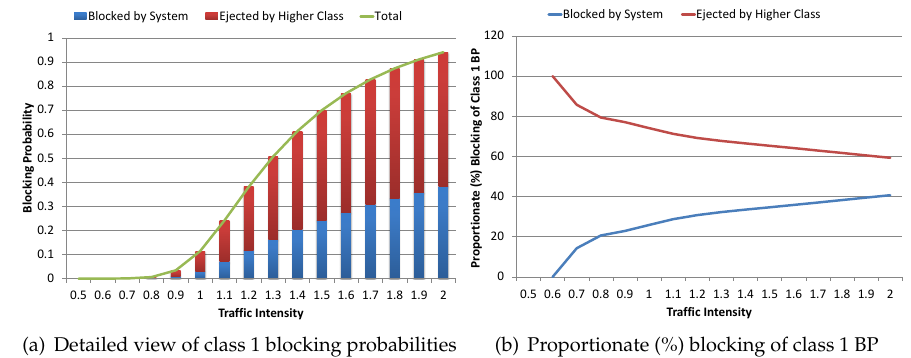
Figure 13. Analysis of blocking probabilities components for class 1 using preemptive model results with C = 30